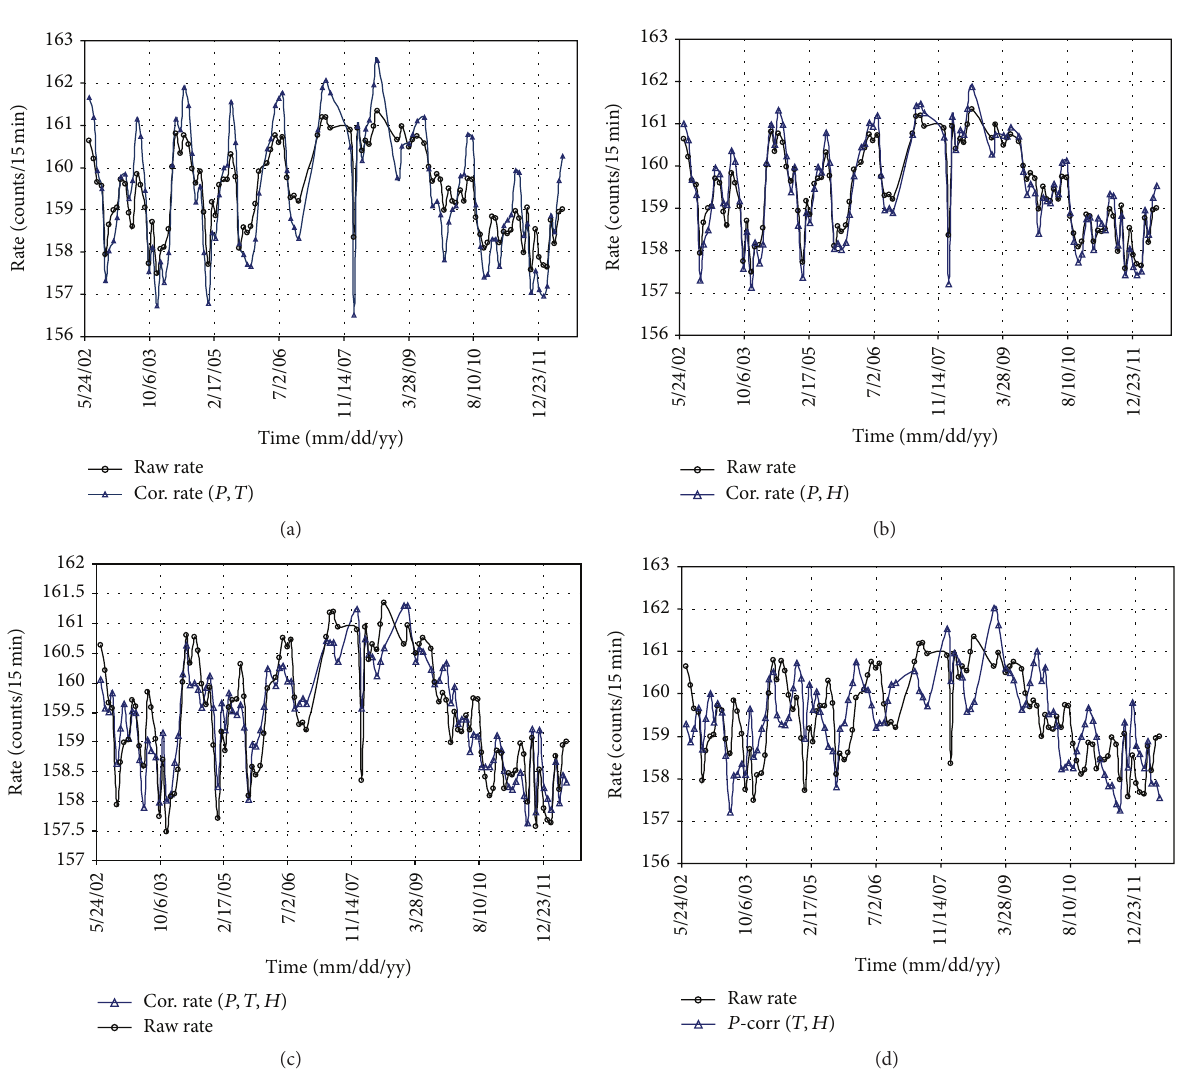
Figure 5: Frequency distribution of the calculated coefficients for (a) 𝛼 and 𝛽 , (b) 𝛼 and 𝛾 , (c) 𝛼 , 𝛽 , and 𝛾 , and (d) 𝛾 and 𝛽 obtained from the regression analysis between pressure-corrected muon rate and both the level and the temperature at the production level.